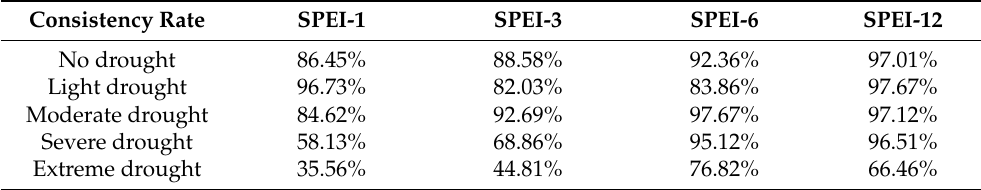
Table 7. Drought categorization consistency rate between CDI and SPEI at each